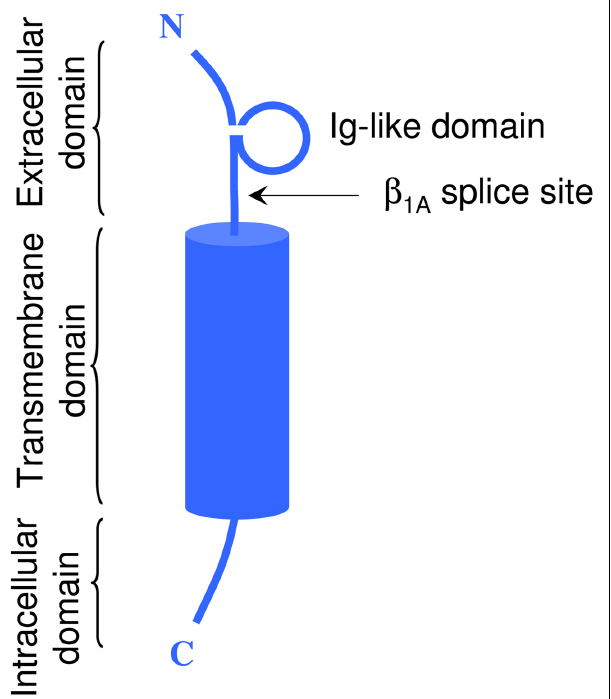
Table 2 |Tissue distribution of auxiliary β subunits.